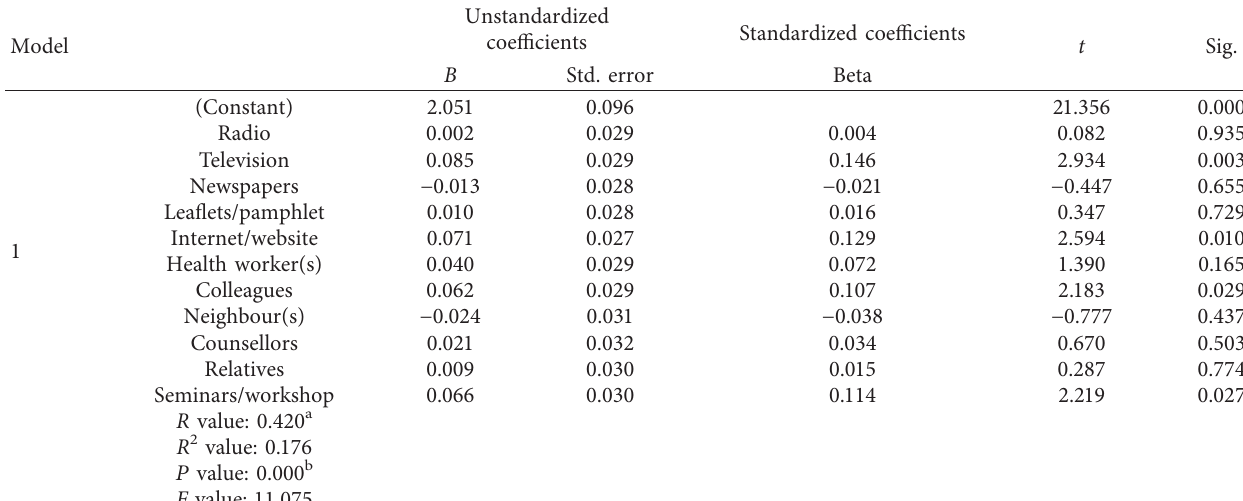
Table 6: Coefficients of health communication channels and preventive practices of HBV.